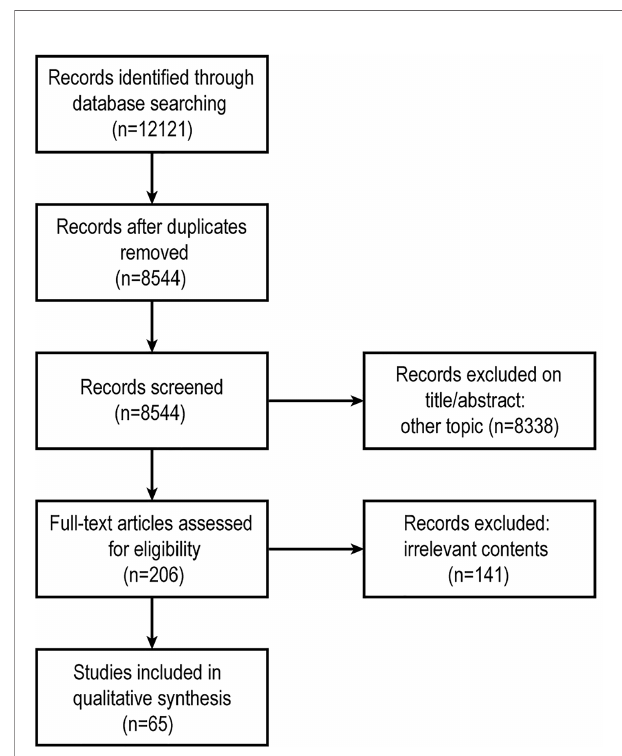
FIGURE 1 | Schematic of study